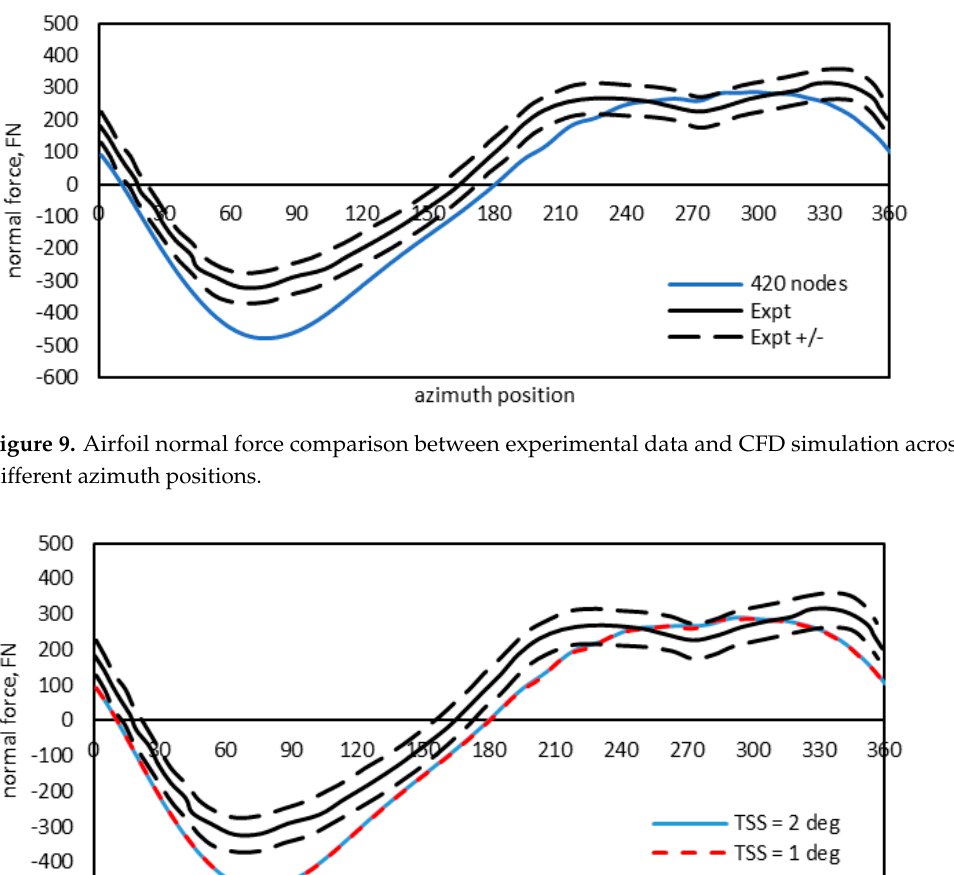
Figure 8. Node density study for the validation case.